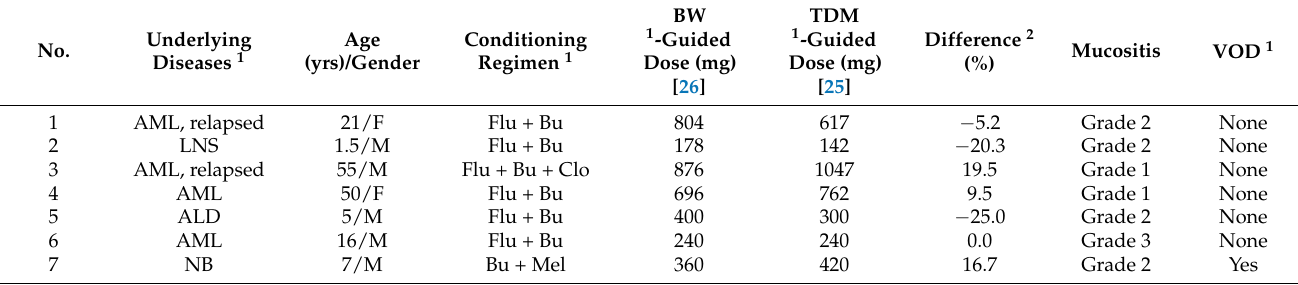
Table 4. Clinical patient